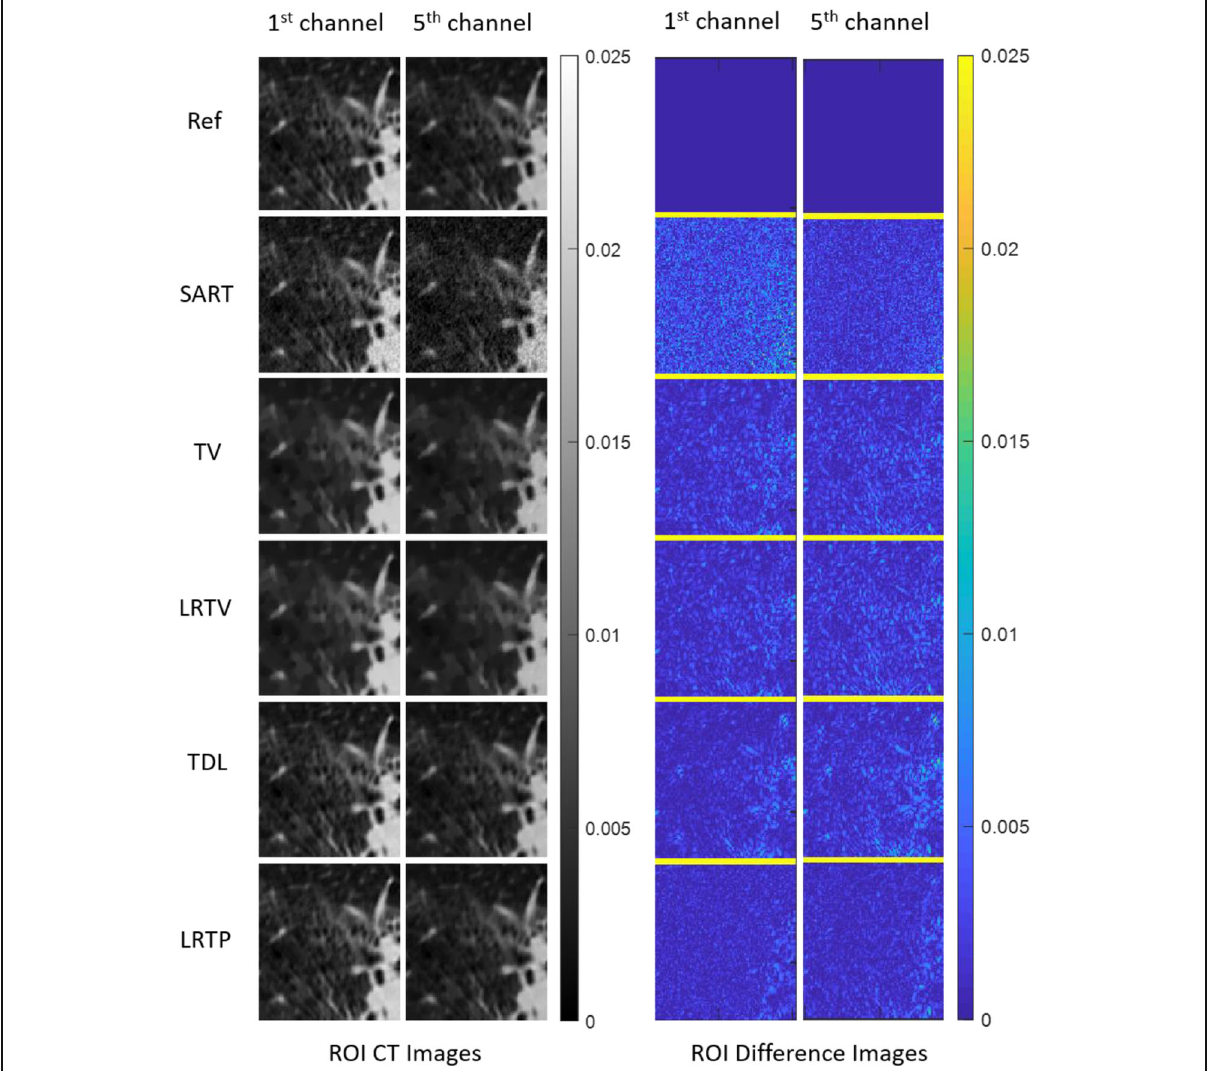
Fig. 7 Close-up views for comparison of lung region of interests reconstructed by different algorithms. The gray level images are the magnified lung ROI CT images in the red box in Fig. 1. The corresponding absolute difference images are shown in color. From top to bottom are the reference images reconstructed from full-dose projections by SART and the low-dose images reconstructed by SART, TV, LRTV, TDL and LRTP methods, respectively. ROI Region of interest; CT Computed tomography; TV Total variation; LRTV Low rand total variation; TDL Tensor dictionary learning; SART Simultaneous algebraic reconstruction technique; LRTP Low rank texture